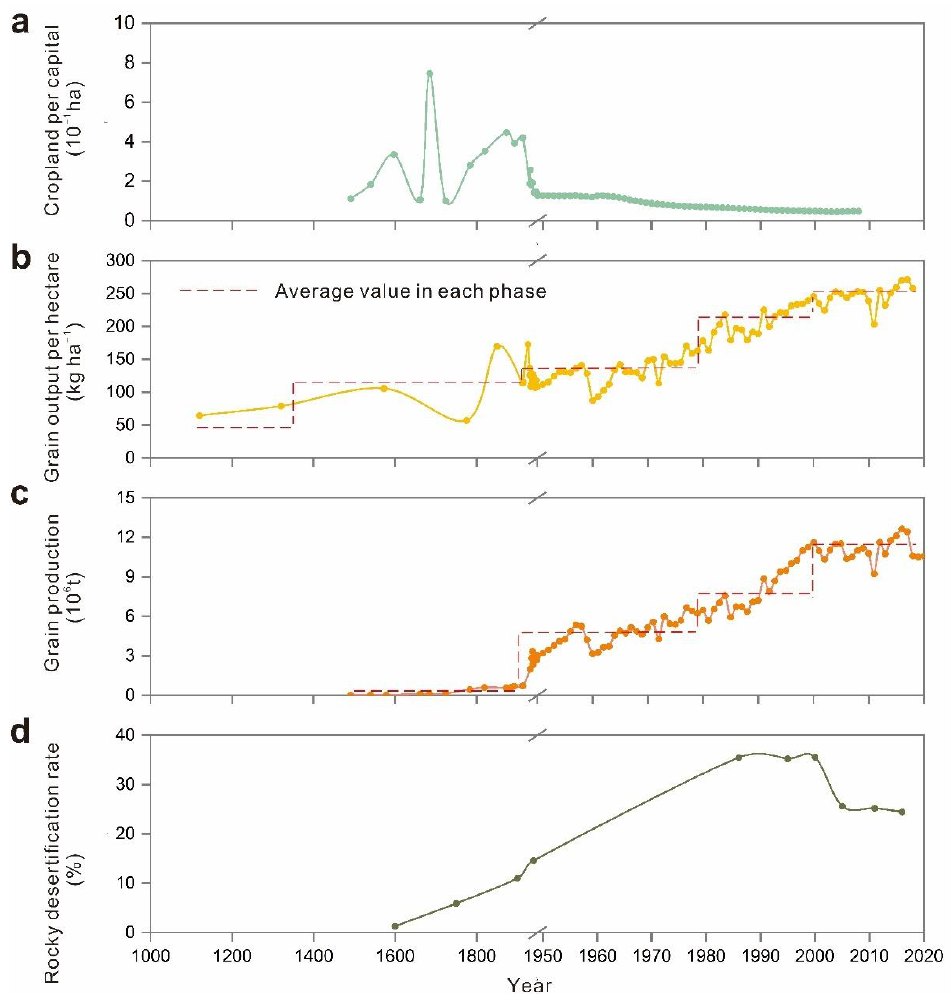
Figure 7. Effects of change in socio-ecological interactions on ( a ) cropland area per capital, ( b ) grain output per hectare, ( c ) grain production, and ( d ) rocky desertification rate.